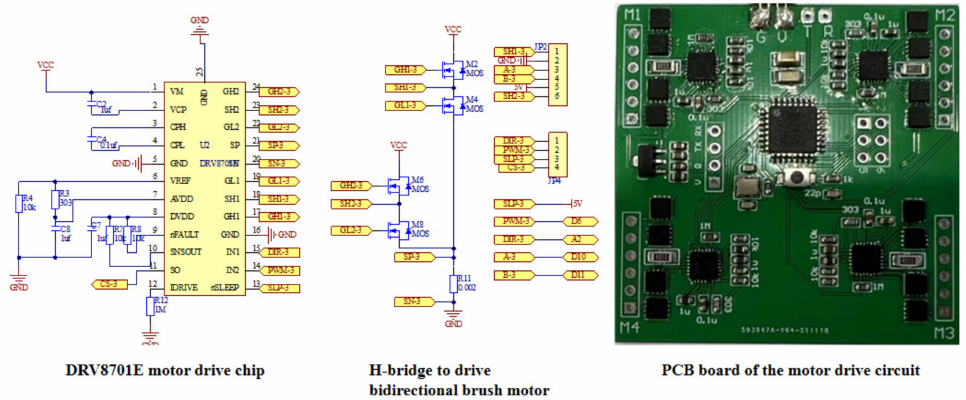
Figure 17. Hardware setup for reconfigurable modular vehicles.